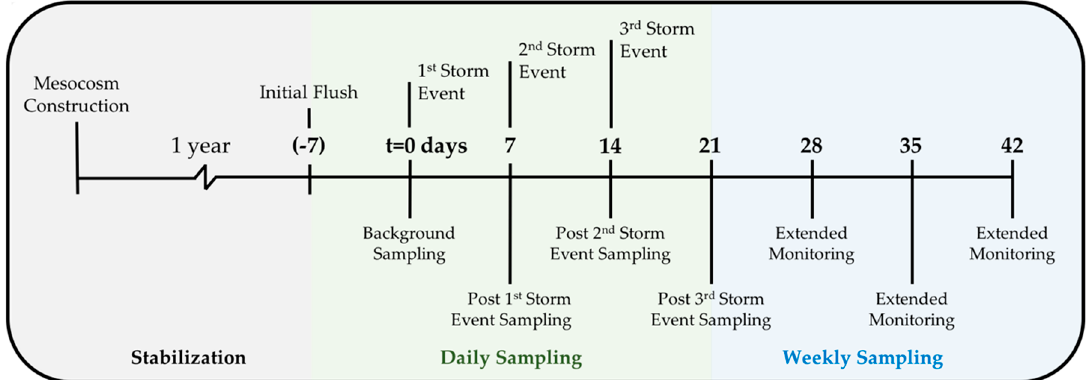
Figure 2. Timeline depicting biofilter mesocosm construction, initial flush ( t = − 7 days), three weekly storm events ( t = 0, 7, 14 days), and extended monitoring period ( t = 28, 35, 42 days). Daily monitoring occurred from t = − 7–21 days, after which addition monitoring occurred on t = 28, 35, 42 days.